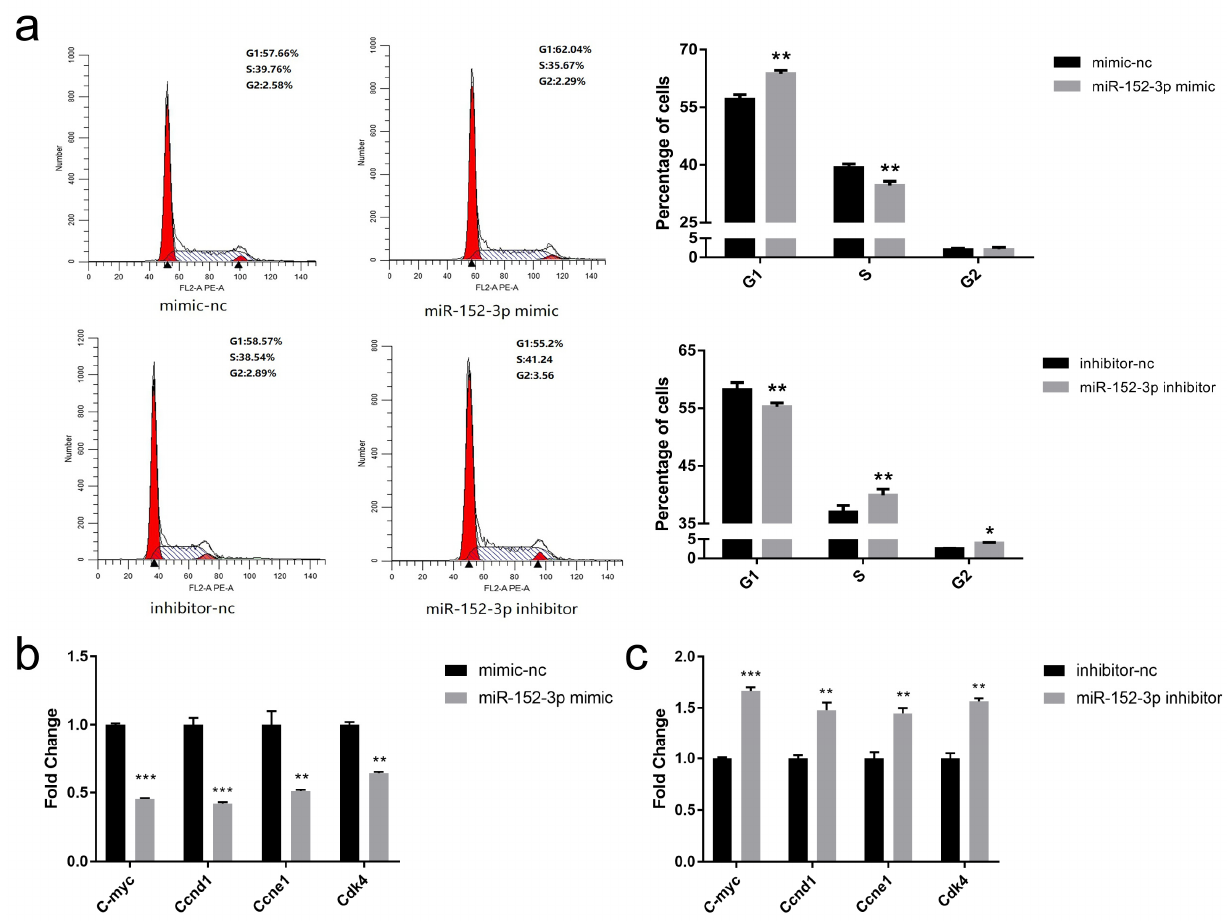
Figure 3. The effects of miR-152-3p on the cell cycle of MTEC1 cells. ( a ) The cell cycle of MTEC1 cells was detected by flow cytometry when the miR-152-3p was overexpressed and inhibited. ( b , c ) RT-qPCR was used to detect the expression of the cell cycle-related genes in the MTEC1 cells. The RT-qPCR data were normalized to the level of β -actin for mRNA. Data were expressed as mean ± SD for three biological replicates (Student’s t -test: *, p < 0.05, **, p < 0.01; ***, p < 0.001).